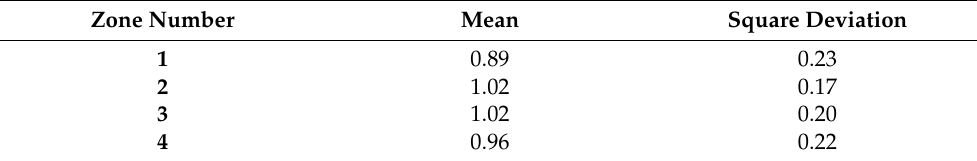
Table 2. Mean and square deviation of A / A ref of different zones of model with θ a = 4 ◦ . Zone Number Mean Square Deviation